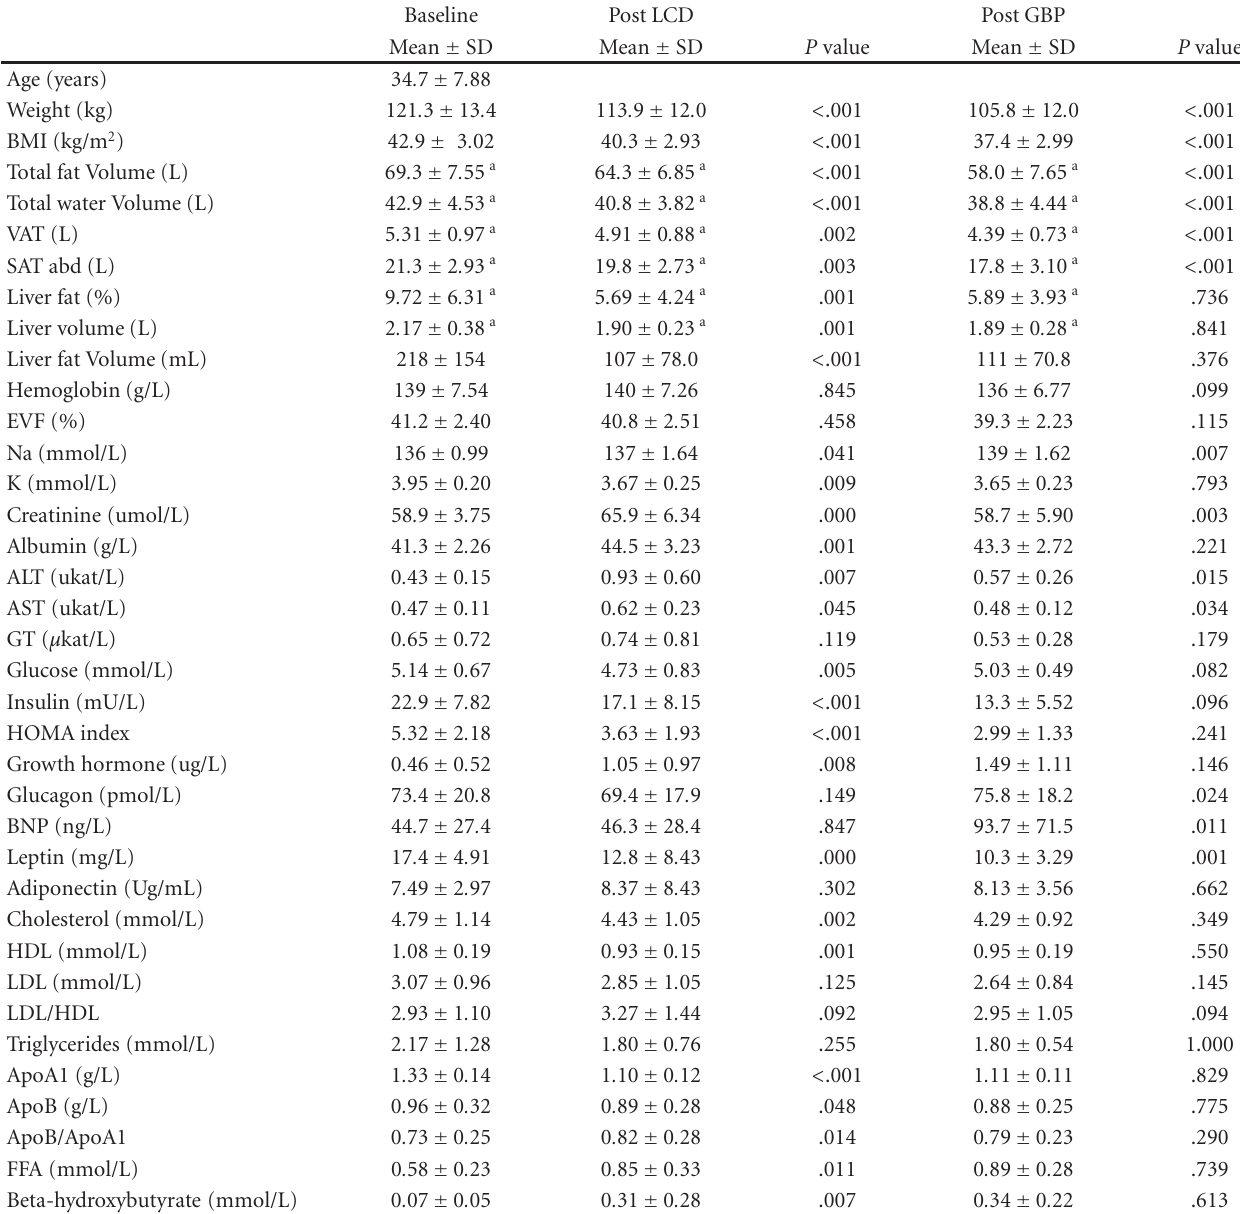
Table 1: Subject characteristics of the 15 females at baseline and after one month of low-calorie diet (LCD) and one month after gastric bypass